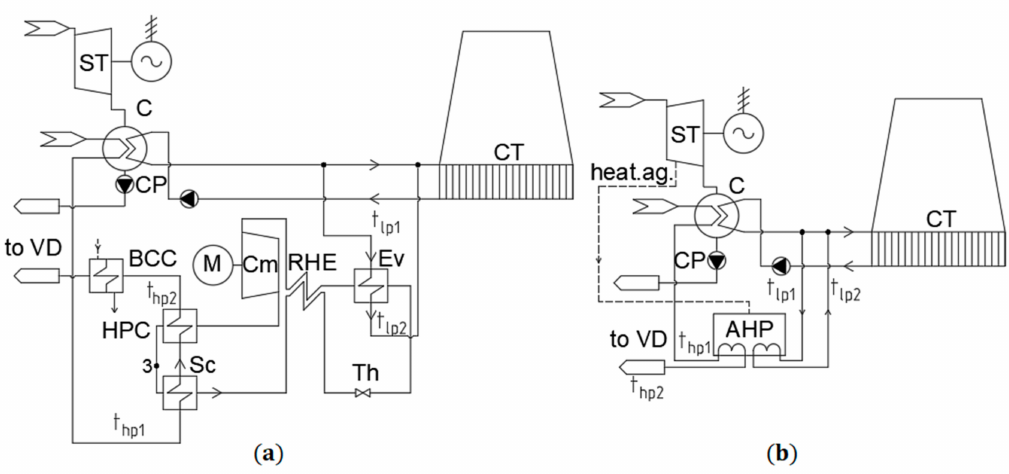
Figure 6. Shemes of integrating VCHP with a RHE and a Sc ( a ), AHP ( b ) for heating make-up water. Circulating water as a LPHS.